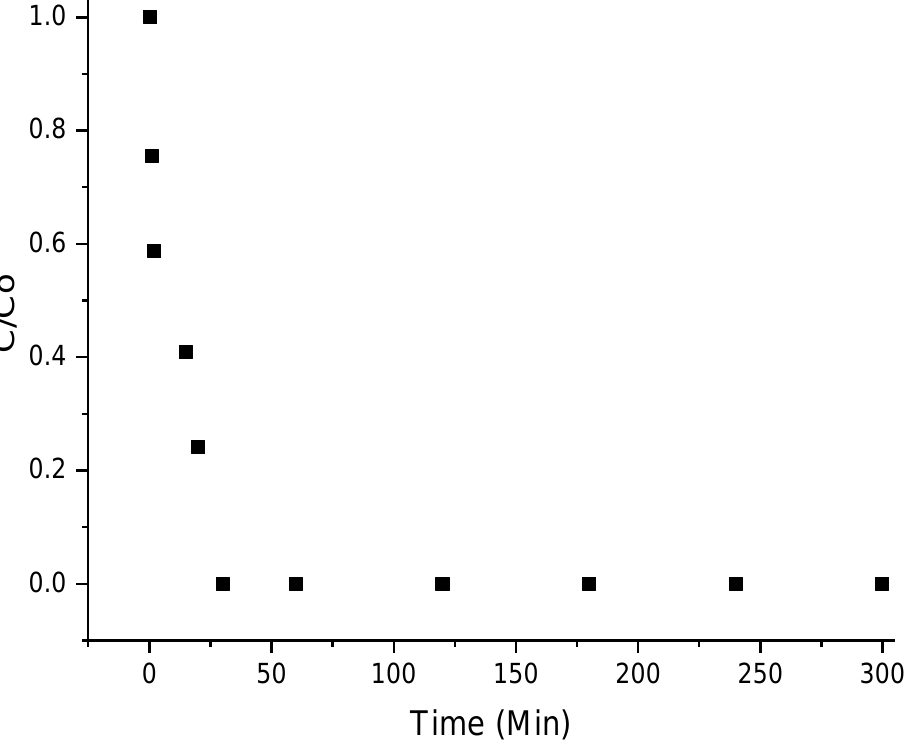
Figure 13. Nominal equilibrium concentration of Mo vs. time for the adsorption of Mo with CDC; CDC loading: 0.6 g/L; pH: 6; agitation speed: 150